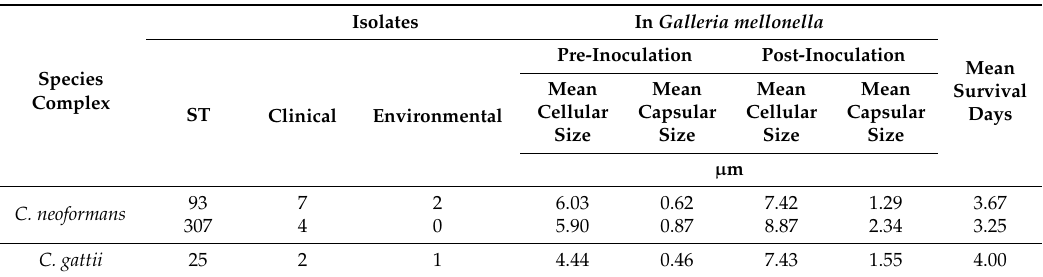
Figure 3. C. neoformans capsules with Indian ink (80 × ). ( A , C ) ST93 clinical isolate (H0058-I-2073), pre and post inoculation; ( B , D ) ST93 environmental isolate (H0058-I-4711) pre and post inoculation. Table 2. Analysis of pre- and postinoculation survival of C. neoformans and C. gattii clinical and environmental isolates inoculated in the invertebrate virulence model of G. mellonella . Association with sequence type (ST).